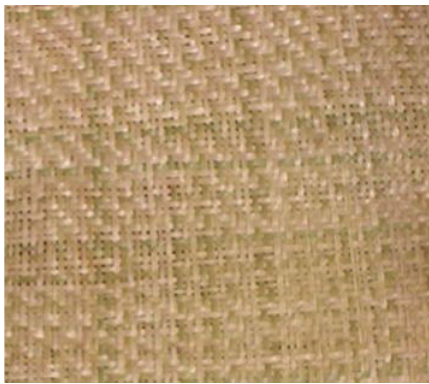
Figure 1: Bidirectional roving bamboo fiber.